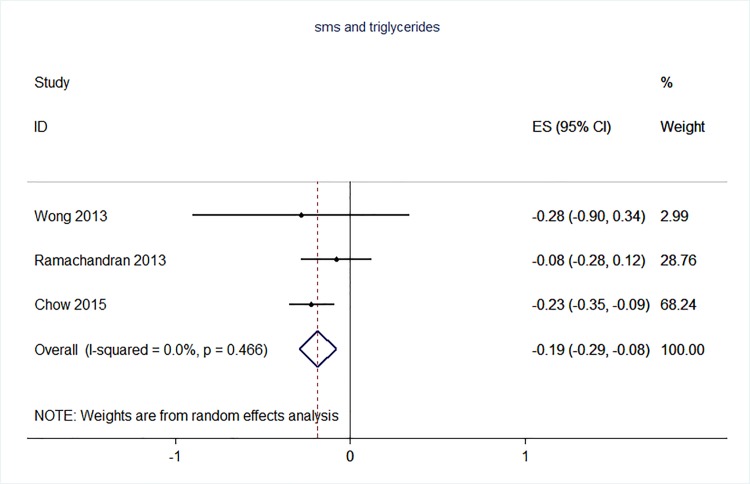
Physical activity and diet interventions using SMS function–triglycerides (mmol/L).